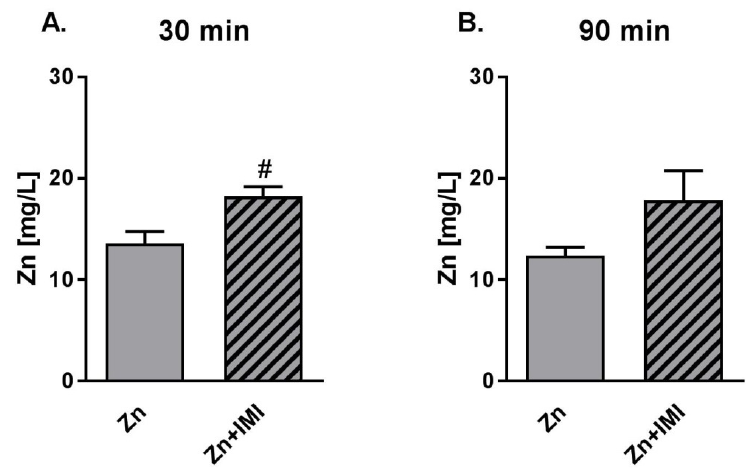
Figure 3. E ff ect of IMI on Zn transport in colon epithelial Caco-2 cells (HTB-37) 30 min ( A ) and 90 min ( B ) after the treatment. Zn (F-AAS) was sampled from below the monolayers of the Caco-2 cells. Results are expressed as mean ± S.E.M, n = 3. # p < 0.05 vs. Zn group ( t -test).